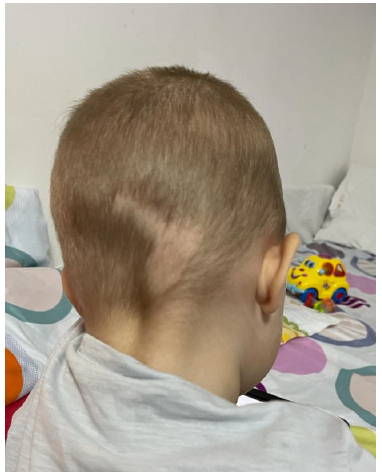
Figure 7. Alopecia areata, a complication during myocardial infarction recovery possibly related to the ACE inhibitors treatment. the ACE inhibitors